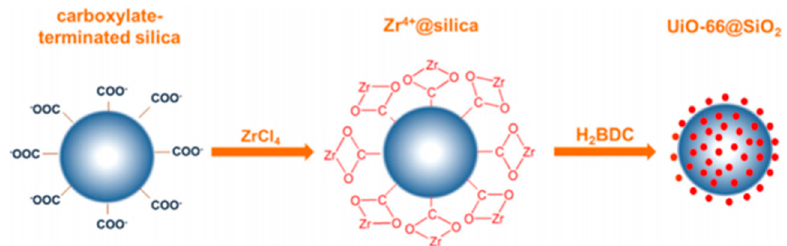
Figure 1. Synthetic procedure of UiO-66@SiO 2 shell-core composites via in situ coating process. Reproduced from [61], with permission from Elsevier, 2019.